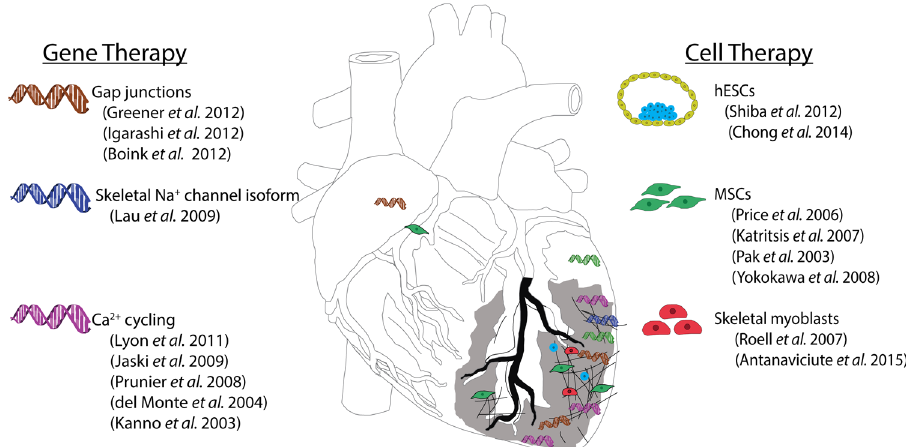
Fig. 2 Scheme representing the discussed gene and cell delivery strategies for altering cardiac conduction, along with the delivery sites. A diseased heart with reduced electrical integrity is represented. Icons positioned on the gray region are indicative of studies involving MI animal models. The cell sources and gene therapies strategies are represented on the side